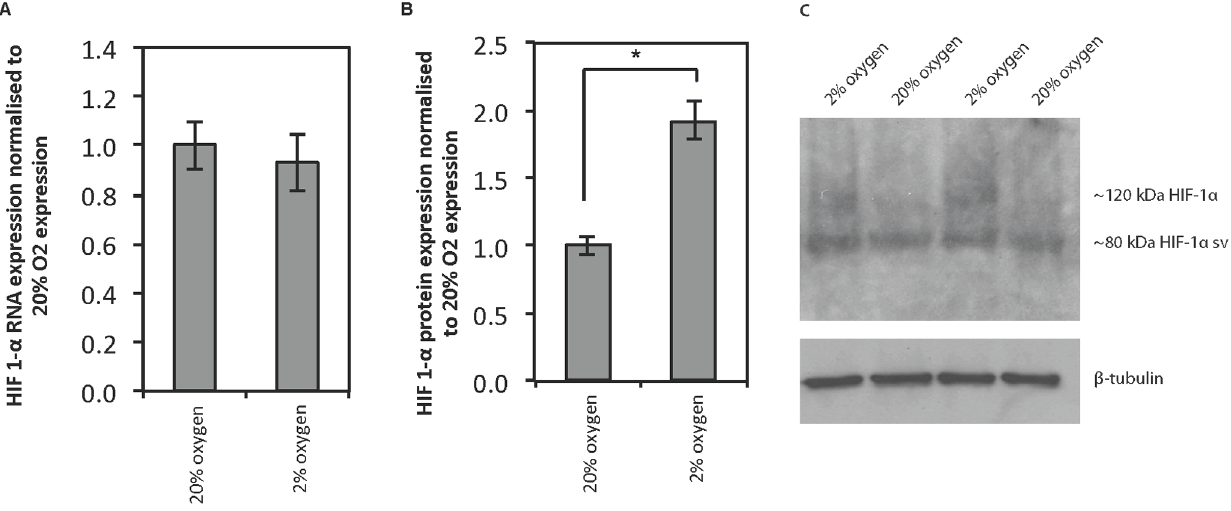
Figure 6. HIF-1 a expression of human embryonic stem cells cultured at physiological and atmospheric oxygen concentrations. HIF- 1 a expression during the exponential phase of growth for hESCs cultured at 20% and 2% oxygen. A) HIF-1 a RNA expression normalised to RNA expression at 20% oxygen. Values are averages 6 standard deviation, n=3. No significant difference was found between HIF-1 a expression at the RNA level at 20% oxygen compared with 2% oxygen. B) Total HIF-1 a protein expression normalised to protein expression at 20% oxygen. Protein expression measured by densitometry analysis of a western blot. Values are averages 6 standard deviation, n=2. * indicates a p-value , 0.5, deemed statistically significant. C) Western blot showing protein probed for HIF-1 a (both 120 kDa form and the 80 kDa splice variant (sv)) and b -tubulin as a loading control.